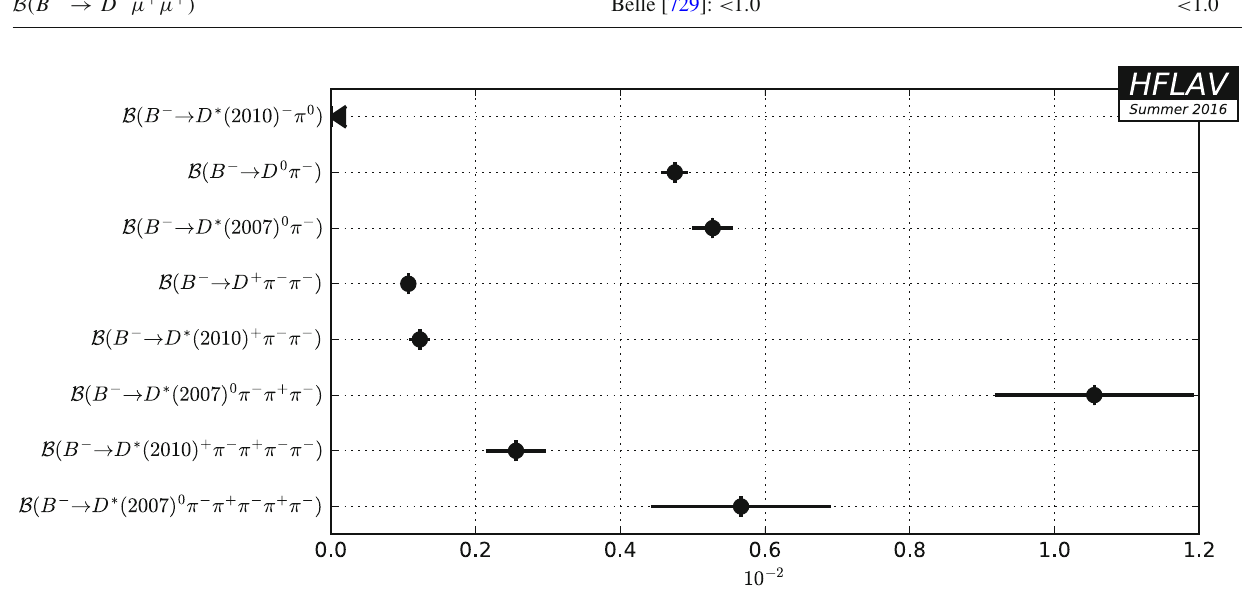
Fig. 106 Summary of the averages from Table 135